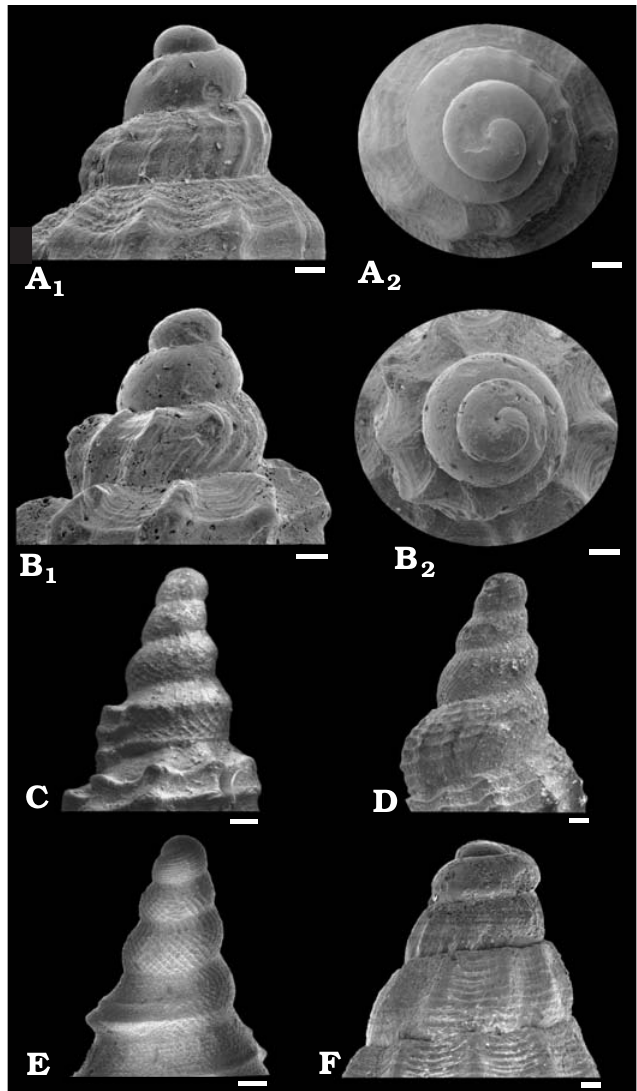
Fig. 7. SEM images of protoconch features of conoidean gastropods from early Serravallian of western Ukraine, Varovtsi (A, C–F) and Horodok (B). A . Bela ? robusta sp. nov., MGGC-24519/8. B . Pyrgocythara turrispira- lata sp. nov., MGGC-24515/11. C . Raphitoma cf. R. ringicula (Boettger, 1902), MGGC-24522/5. D . Andonia sp. aff. A. transsylvanica (Hoernes and Auinger, 1890), MGGC 24523/2. E . Teretia cf. T. turritelloides (Bellardi, 1847), MGGC-24524/5. F . Haedropleura sp. aff. H. septangu- laris (Montagu, 1803), MGGC-24520/6. Views: A 1 , B 1 , C–F, lateral; A 2 , B 2 , apical. Scale bars 0.1